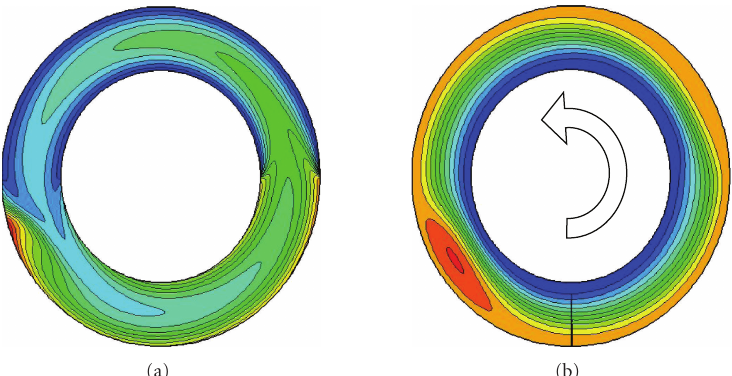
Figure 6: Steady motion in a secondary flow regime; Ra = 22 500, R = 1 . 6, and Pr = 5. (a) Isotherms, from 0.05 (blue) to 0.65 (red) in steps of 0.05. (b) Stream function field, from 5 (blue) to 60 (red) in steps of 5.